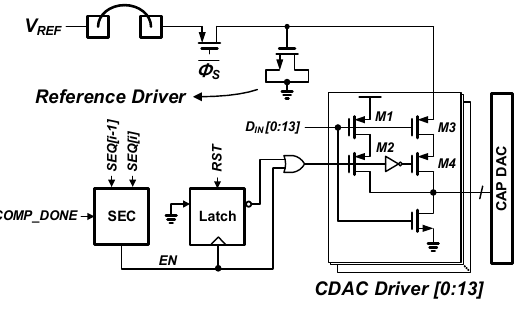
Figure 15. The schematic of the CDAC drivers with the CRD.